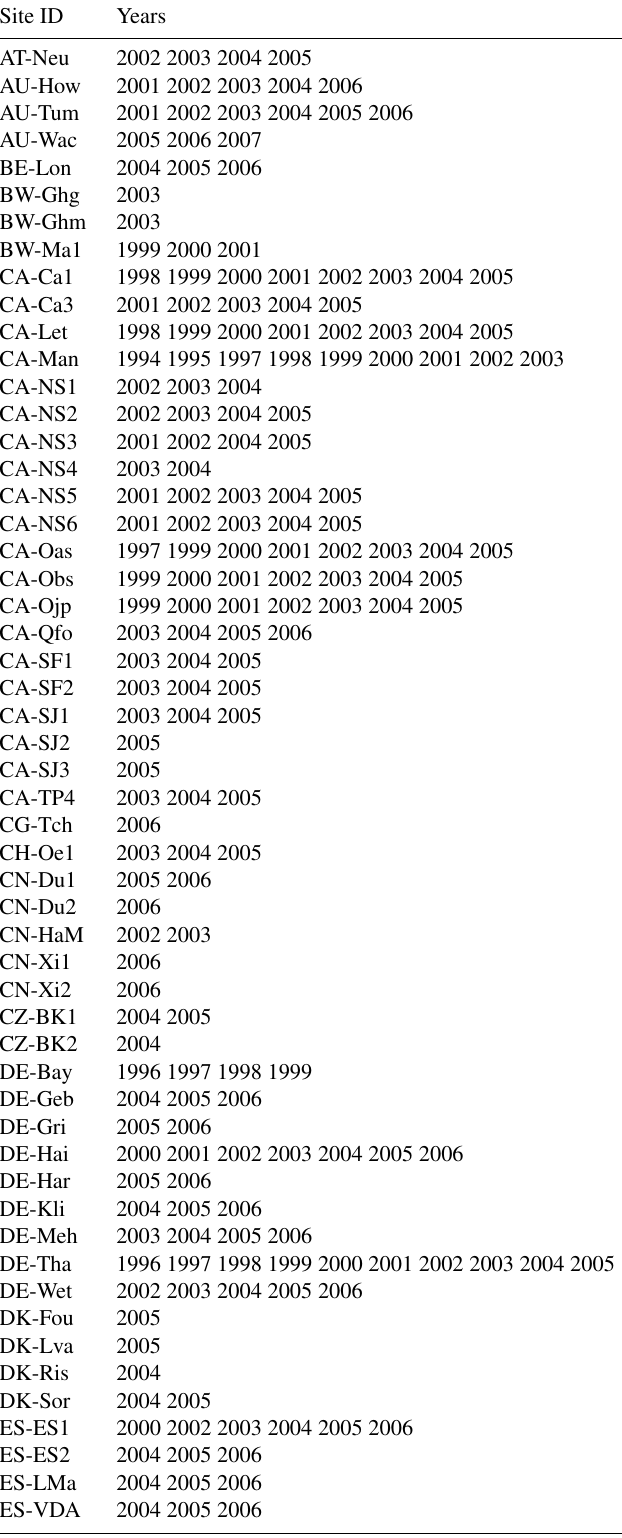
Table A1. FLUXNET site years used in the